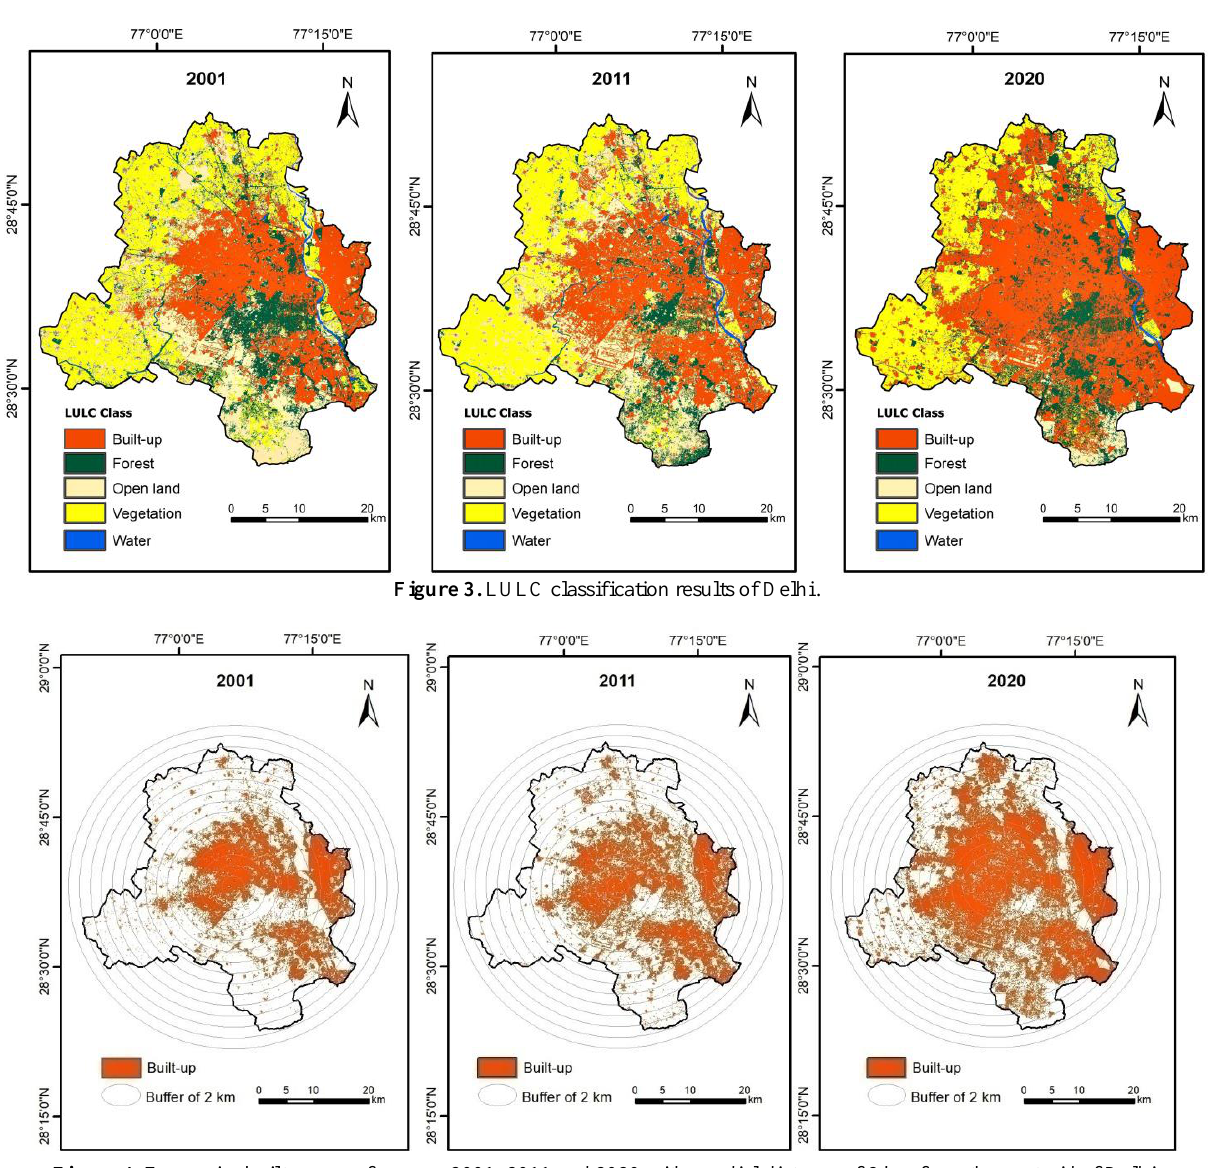
Figure 4. Zone-wise built-up area for years 2001, 2011 and 2020 with a radial distance of 2 km from the centroid of Delhi.